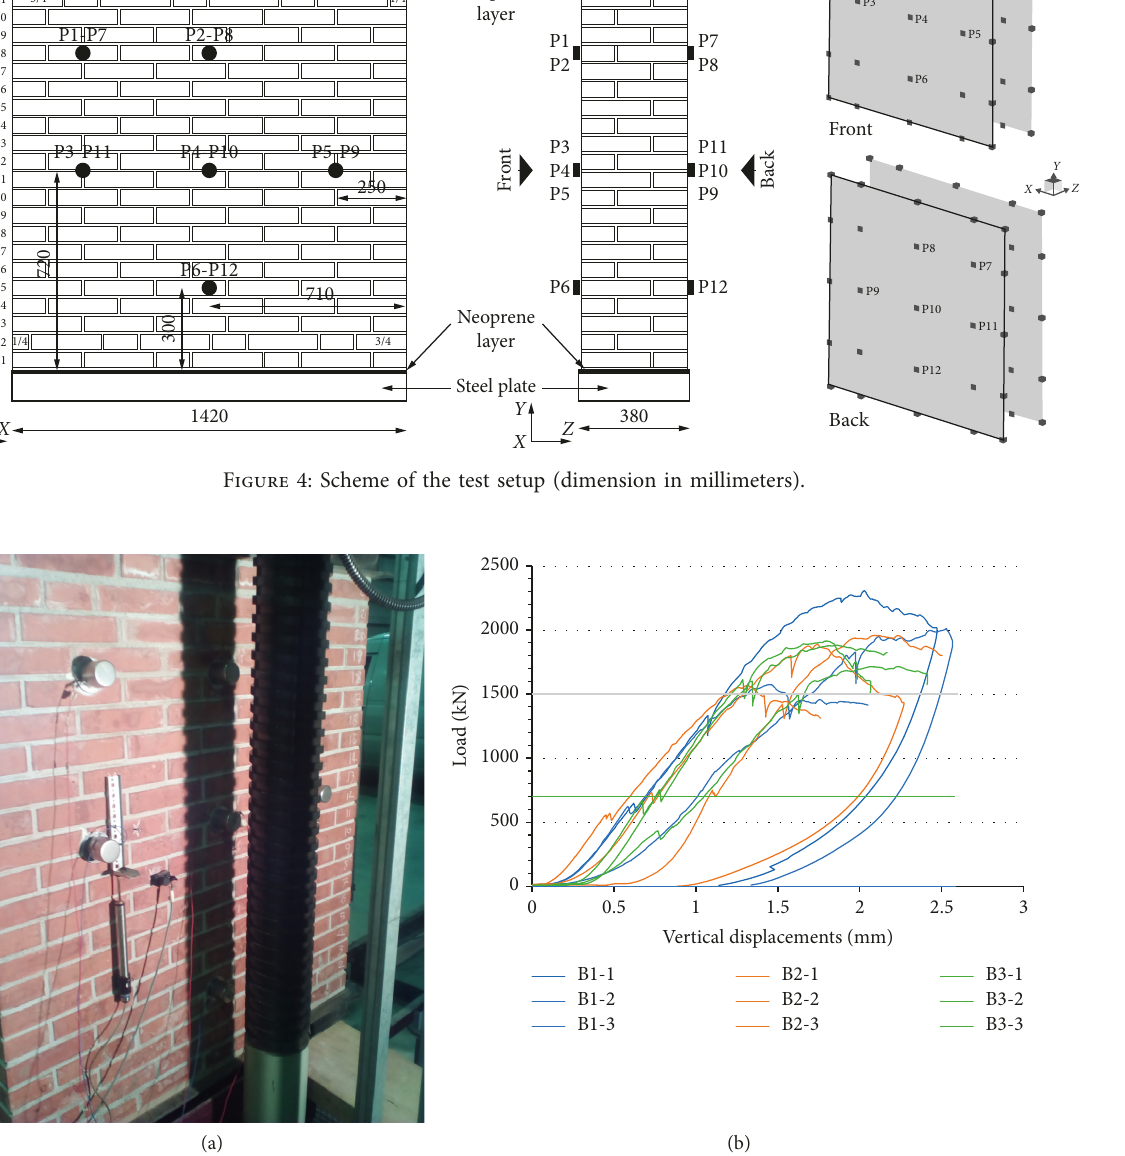
Figure 5: (a) Detail of the test setup; (b) load-vertical displacement relationship with different steps: A, B, and